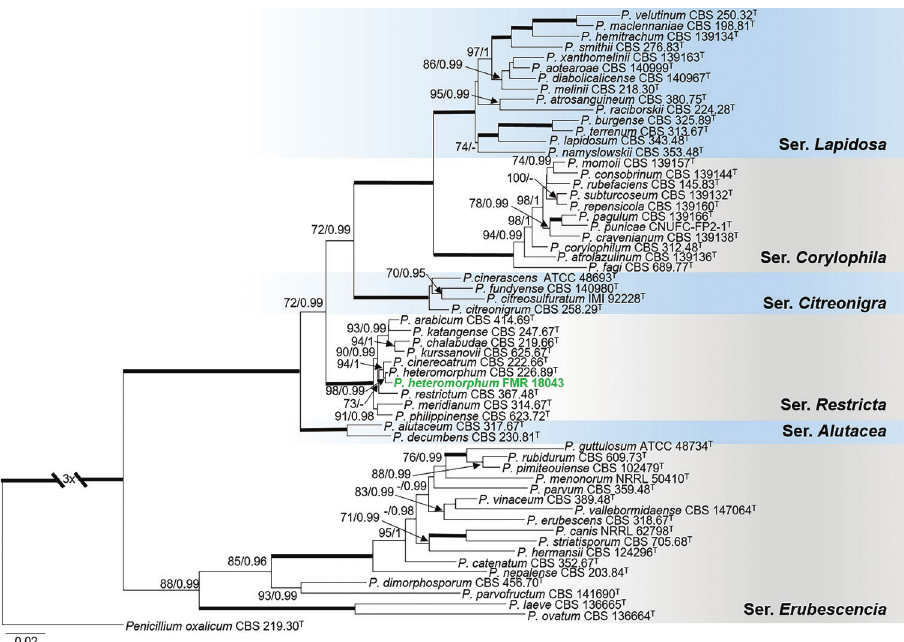
Figure 5. Phylogenetic tree of Penicillium section Exilicaulis based on ML analysis obtained by RAxML inferred from the combined tub 2, cmdA , ITS, and rpb 2 loci. Branch lengths are proportional to phy- logenetic distance. Bootstrap support values/Bayesian posterior probability scores above 70%/0.95 are indicated on the nodes. Bold branches indicate bs/pp values 100/1. The tree is rooted to P. oxalicum CBS 219.30. The name in green is the strain of P. heteromorphum included in this study. T = Ex-type